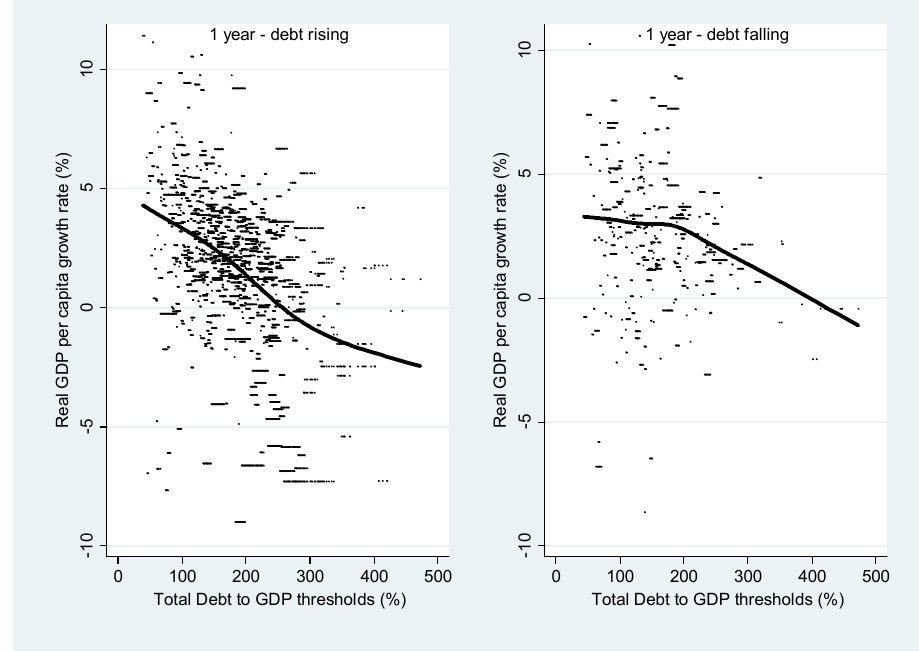
Figure 7 - Debt trajectory and short-term economic